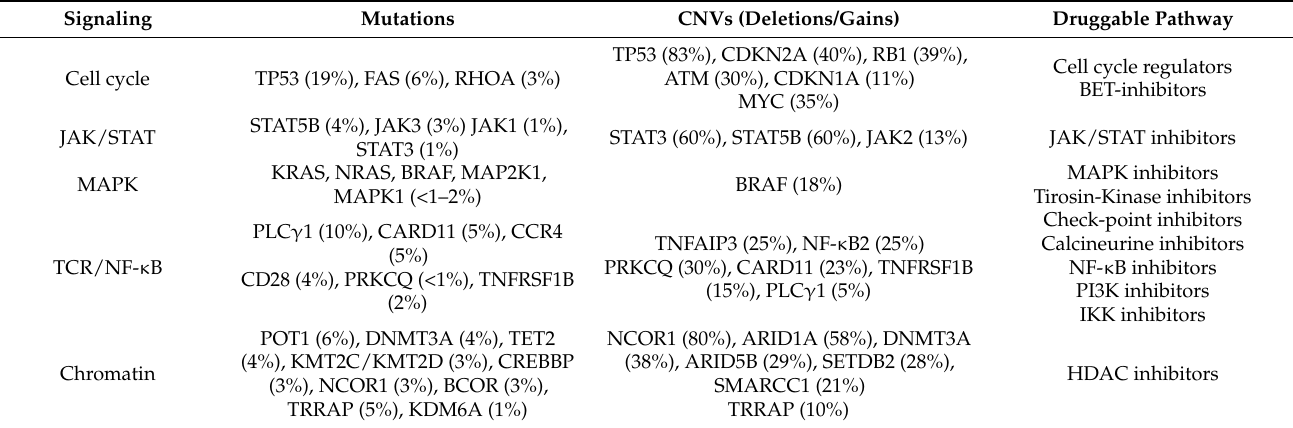
Table 1. Summary of genetic abnormalities reported in MF/SS [11–28].